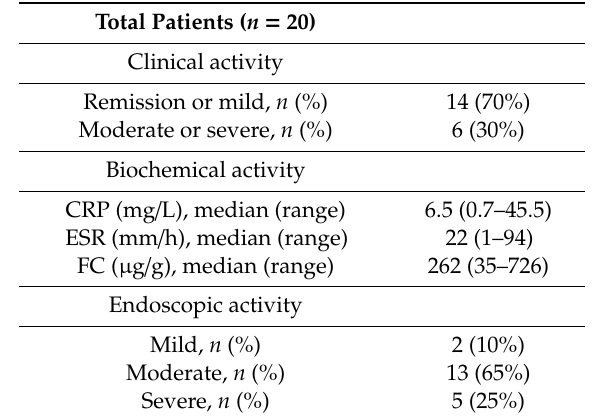
Table 2. Activity according to Harvey-Bradshaw index (HBI) score, biochemical activity and endoscopic activity according to simple endoscopic score for Crohn’s disease (SES-CD) at